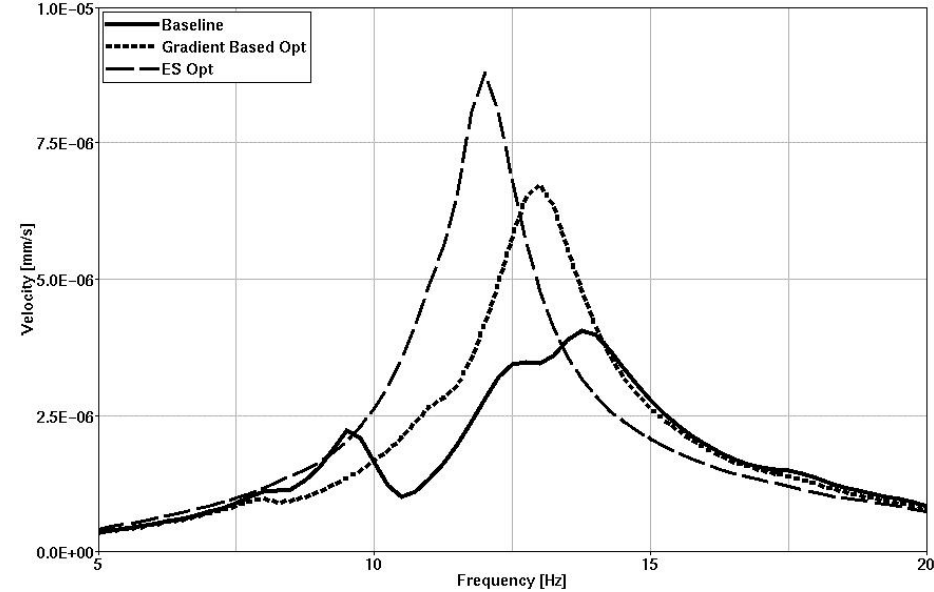
Fig. 9. CG response of the powertrain in the full-vehicle FE model, due to a unit torque about the crank-shaft axis.